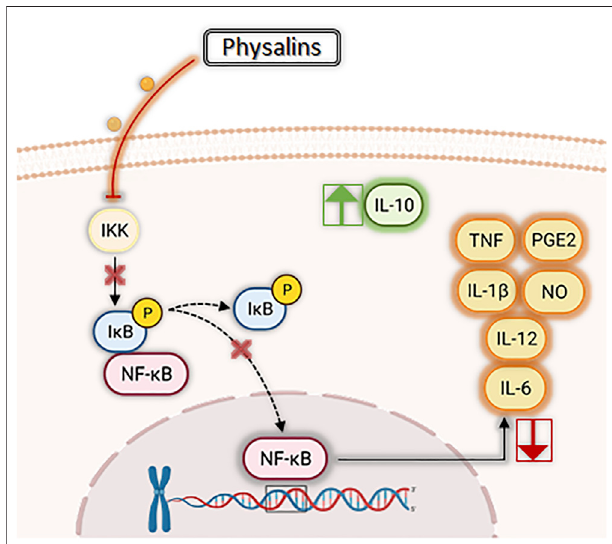
FIGURE 3 | Main anti-in fl ammatory effects of physalins. In general, physalins suppress phosphorylation of i κ B proteins and impair NF- κ B translocation tothe nucleus. NF- κ B isinvolved in the regulation ofseveral pro- in fl ammatory genes, and thus suppression of its activity by physalins results in inhibition ofpro-in fl ammatory mediators, such asinterleukins(IL)-1 β , IL-6, IL-12, nitric oxide (NO), prostaglandin E 2 (PGE 2 ), and tumor necrosis factor (TNF). In addition, some physalins (such as physalin F and H) increase the production of IL-10, a well-known anti-in fl ammatory